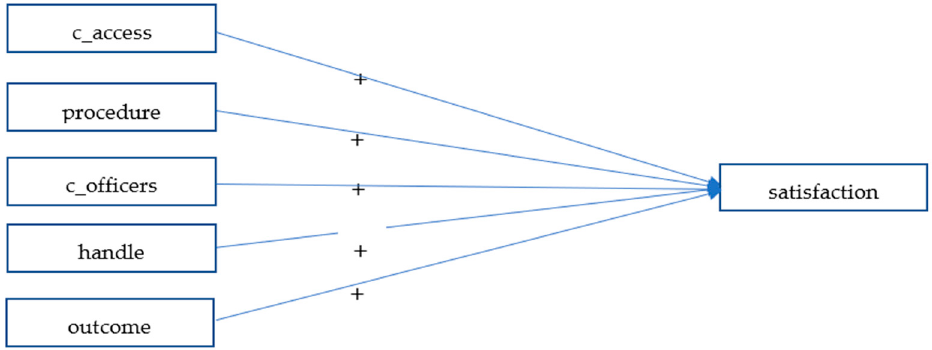
Figure 1. The research